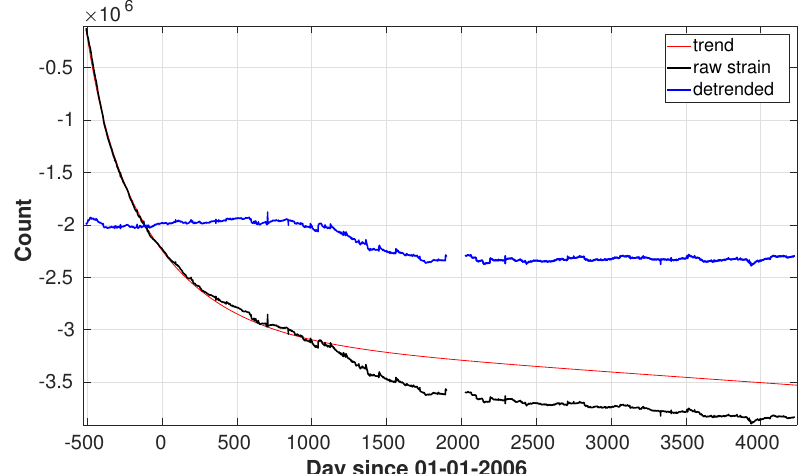
Figure 5. Example of exponential trend induced by grout curing and stress relaxation recorded by station ZANB. Expansion is